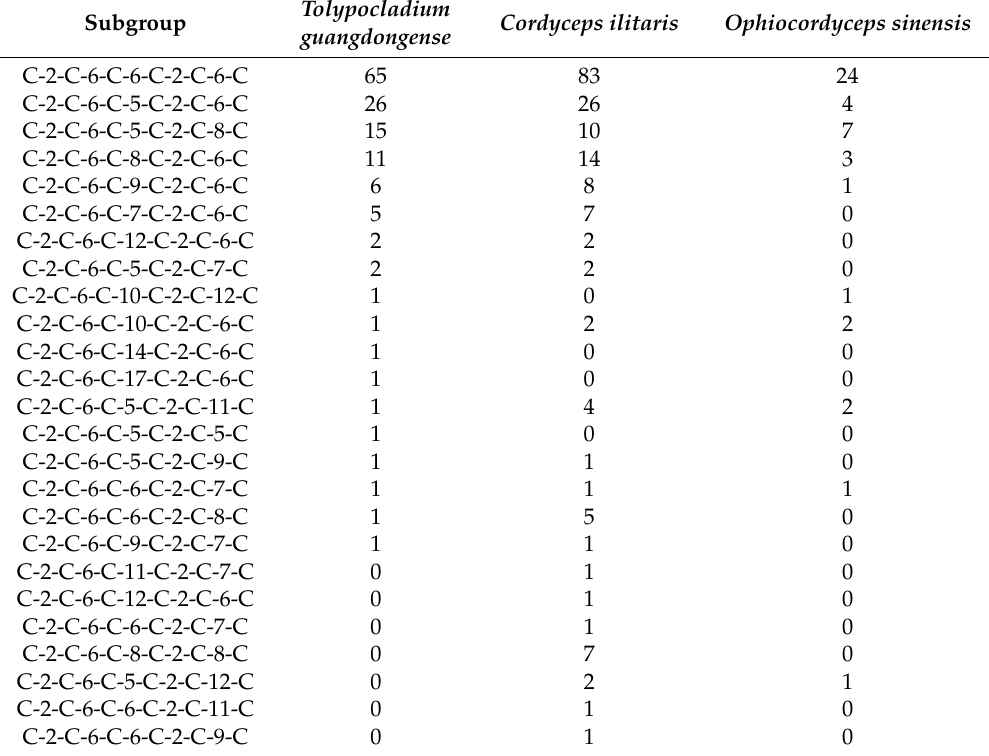
Table 1. Classification and comparison of C6 Zinc proteins based on the Zinc cluster DNA-binding domains in three